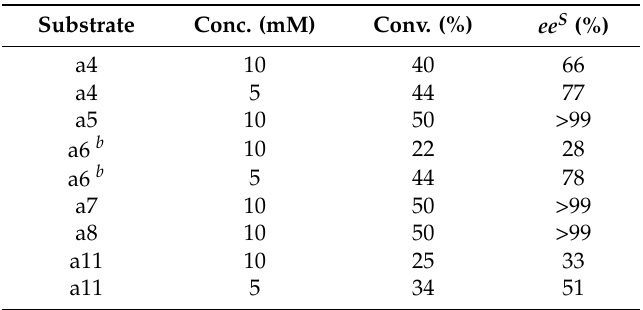
Table 1. Kinetic resolution of various amines using AmDH/Nox a . Substrate Conc. (mM) Conv.